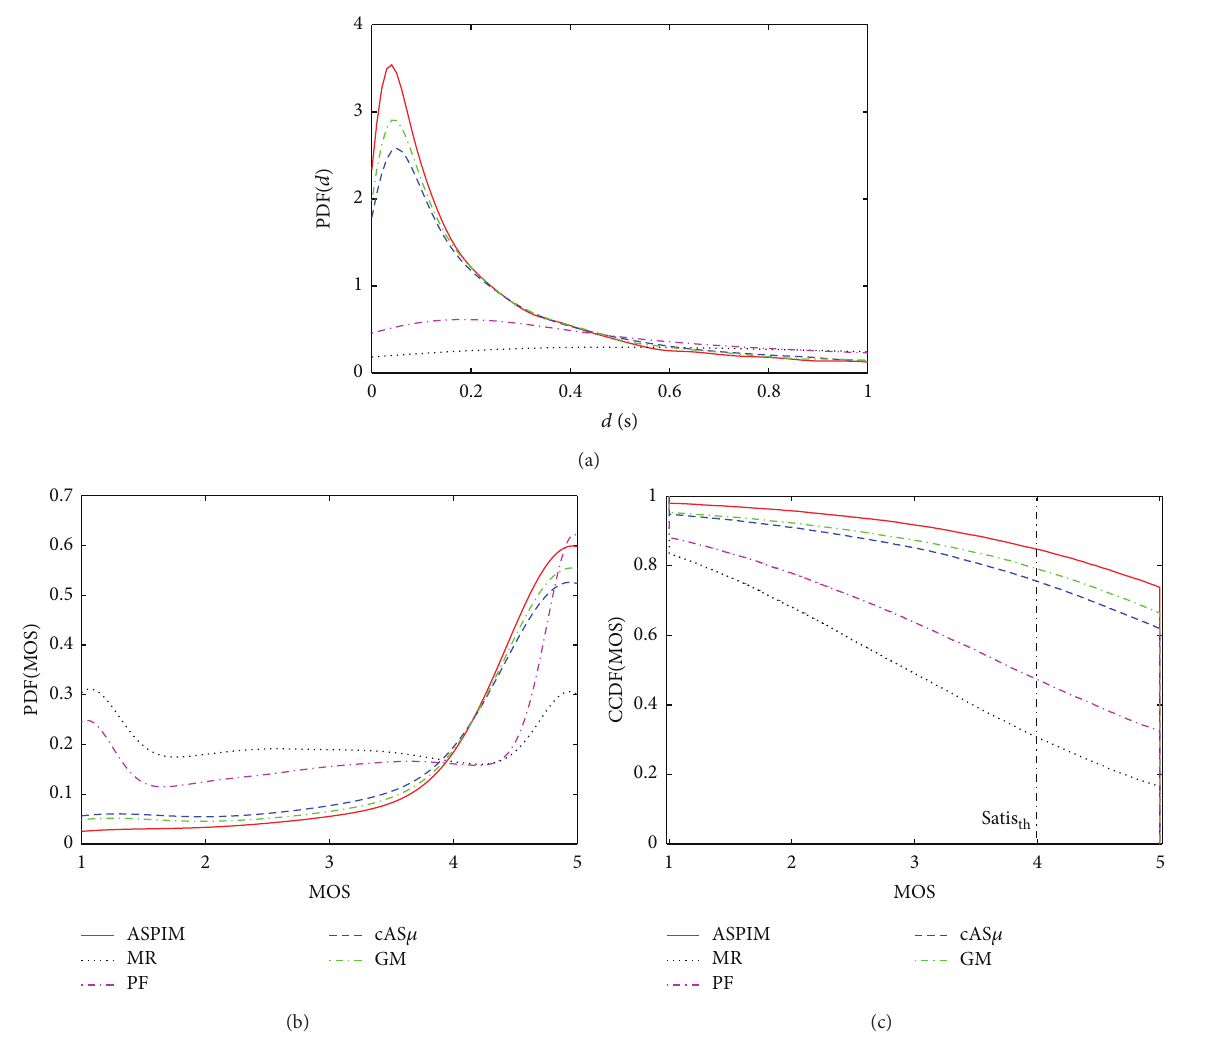
Figure 6: Statistics in Scenario 1: delay PDF (a), MOS PDF (b), and MOS CCDF